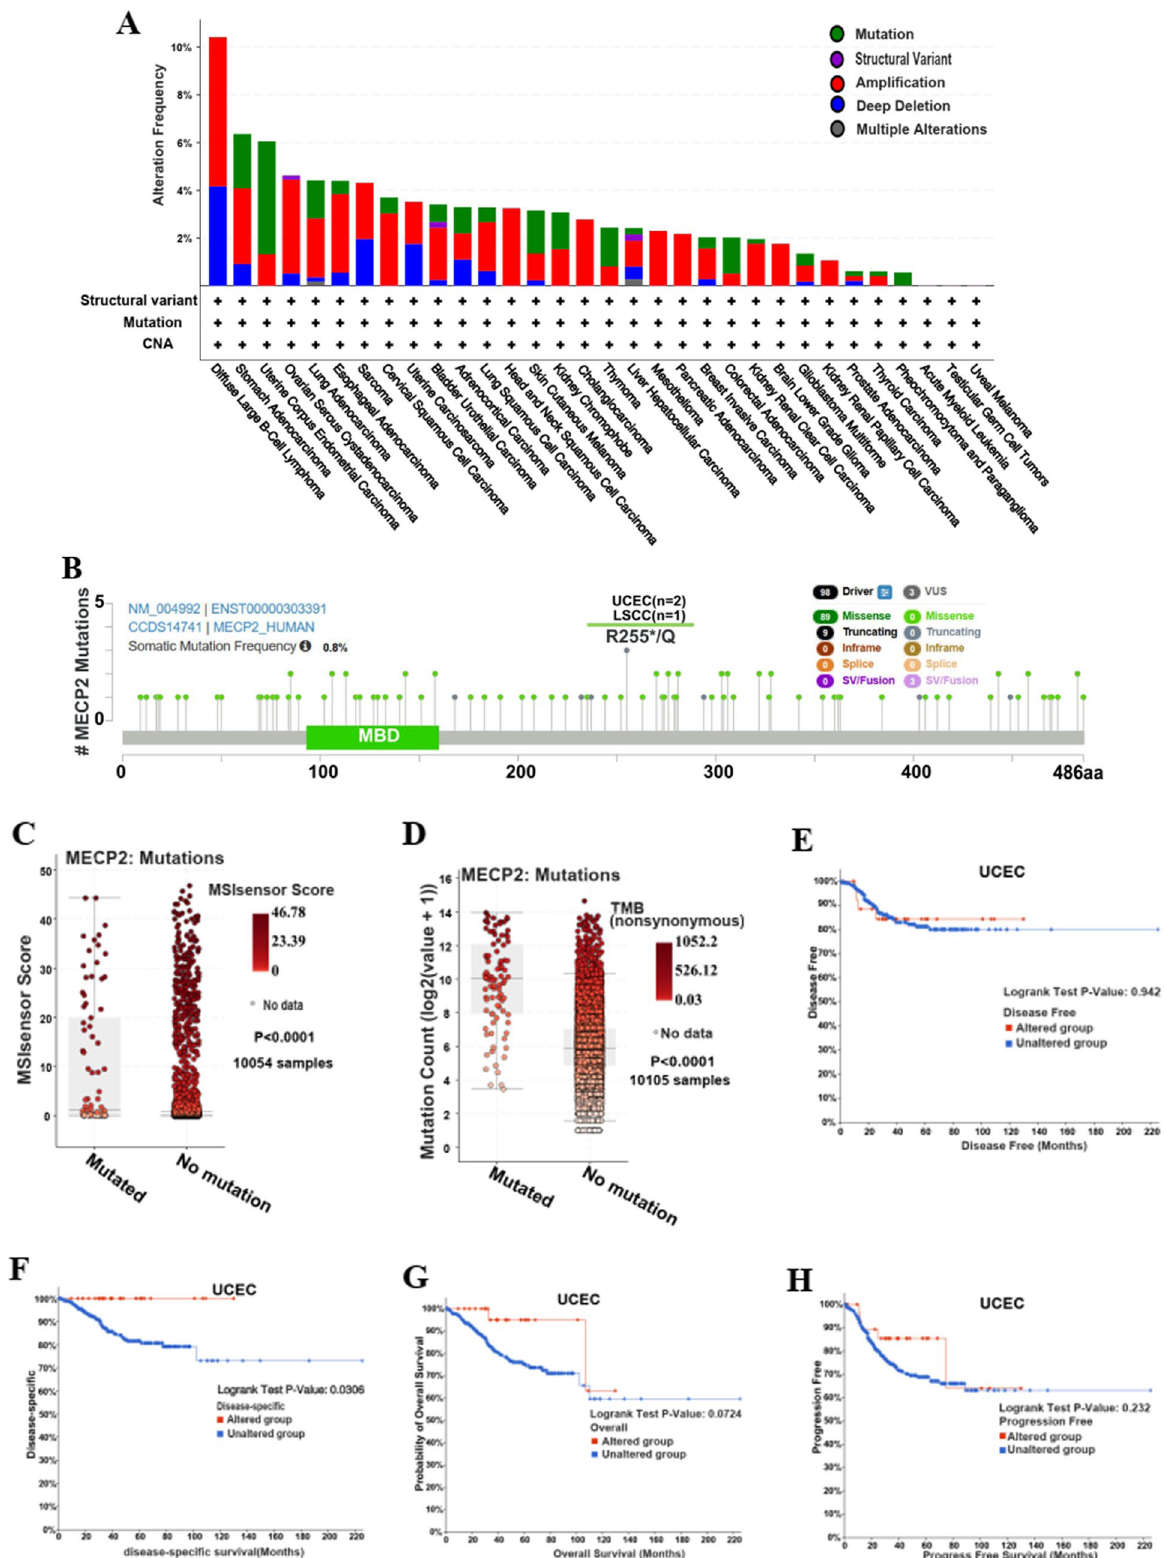
Figure 4. Genetic alterations of MeCP2 in a variety of tumor types. (A) The alteration frequency of MeCP2 in different cancers. (B) The mutation site of the MeCP2 gene. (C,D) The correlation of MeCP2 mutation with MSI sensor score and Mutation count ( P < 0.0001). (E,F) The correlation between MeCP2 mutation and Disease Free, Disease Specific ( P < 0.05), Overall survival, and Progression Free. (I–J) Radar chart displays the correlation between MeCP2 and both TMB andMSI. * P < 0.05, ** P < 0.01, *** P < 0.001, **** P < 0.0001. TMB tumor mutational burden, MSI microsatellite